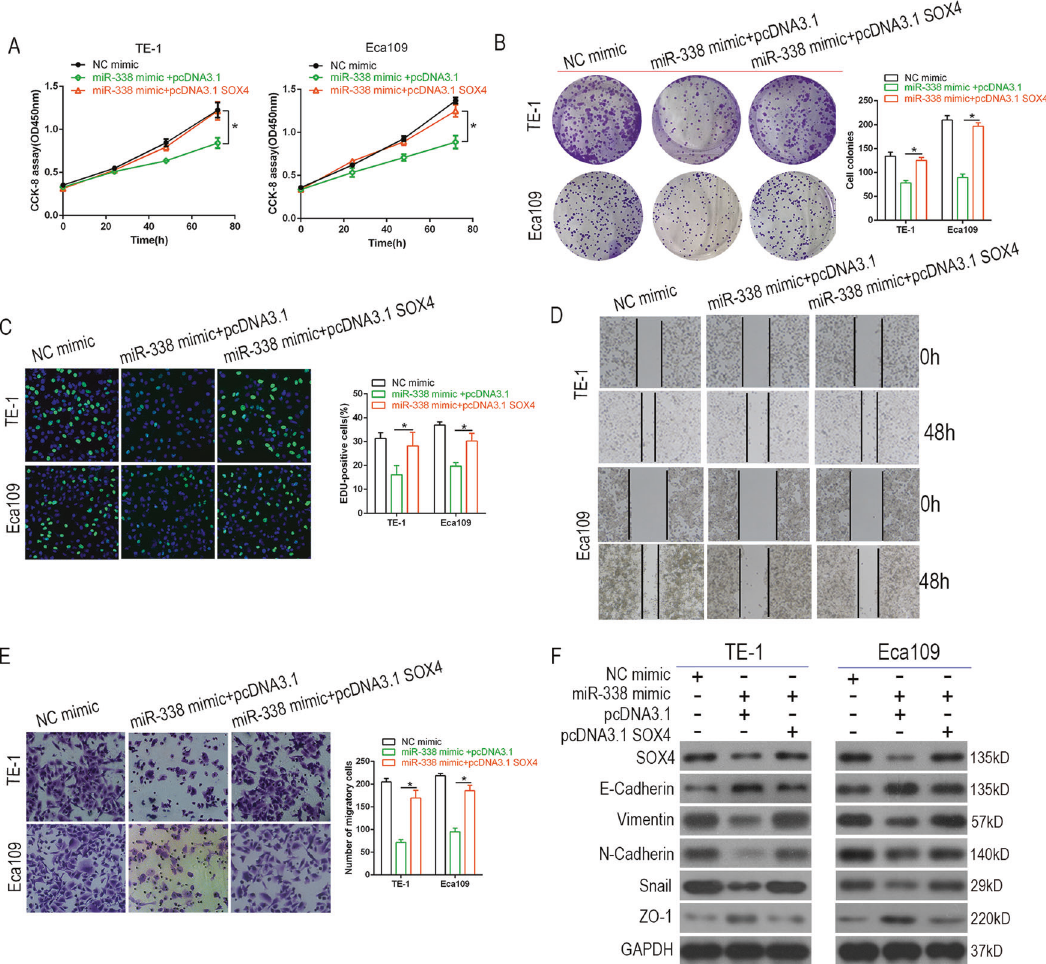
Fig. 7 Restoration of SOX4 reverses the effects of miR-338-3p on ESCC cells proliferation, invasion, and EMT process. A – C CCK-8, colony formation assays, and EdU analysis were performed to determine the proliferation ability of ESCC cells co-transfected with miR-338 mimic and SOX4, respectively. D – F Wound healing and transwell assays and western blot showed the invasion ability and EMT phenotype in ESCC cells co-transfected with miR-338 mimic and SOX4. * P < 0.05 vs.